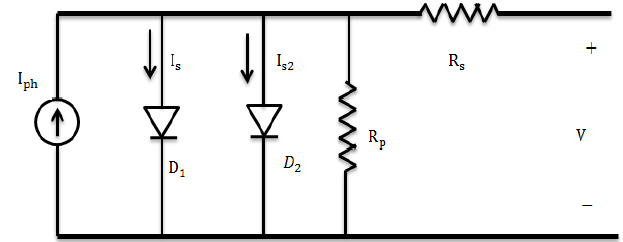
Figure 3. The solar cell electrical equivalent circuit.